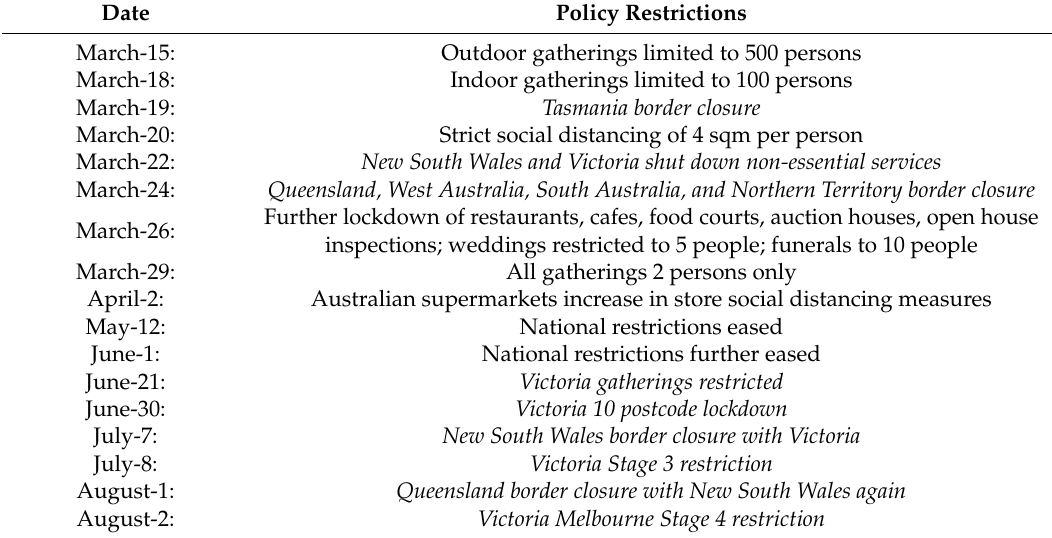
Table 1. Social restriction policies implemented at the national and state level in